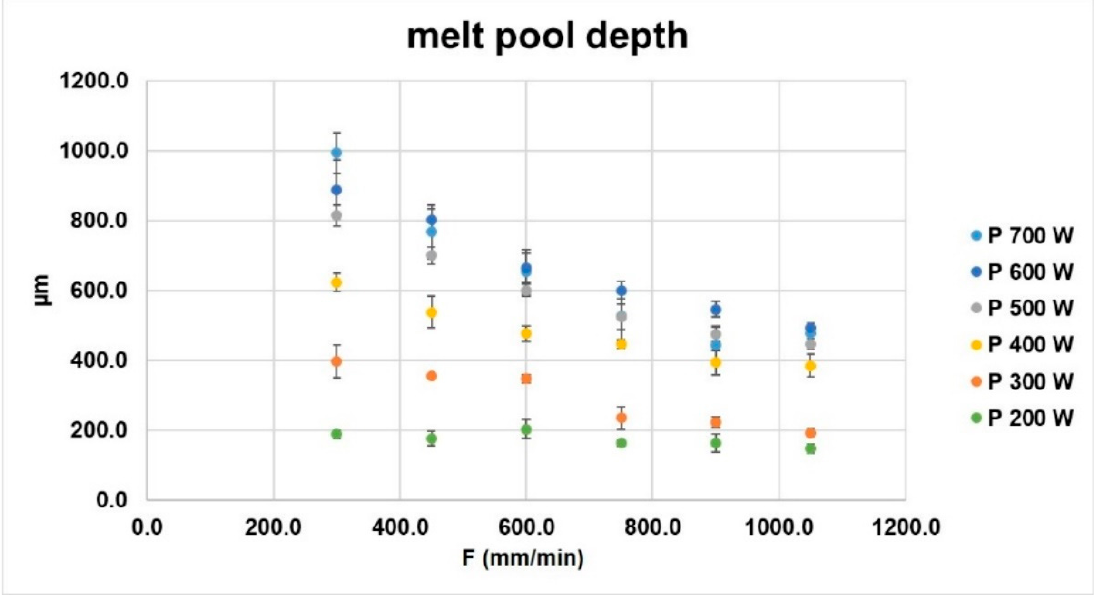
Figure 10. Detected melt pool depth.